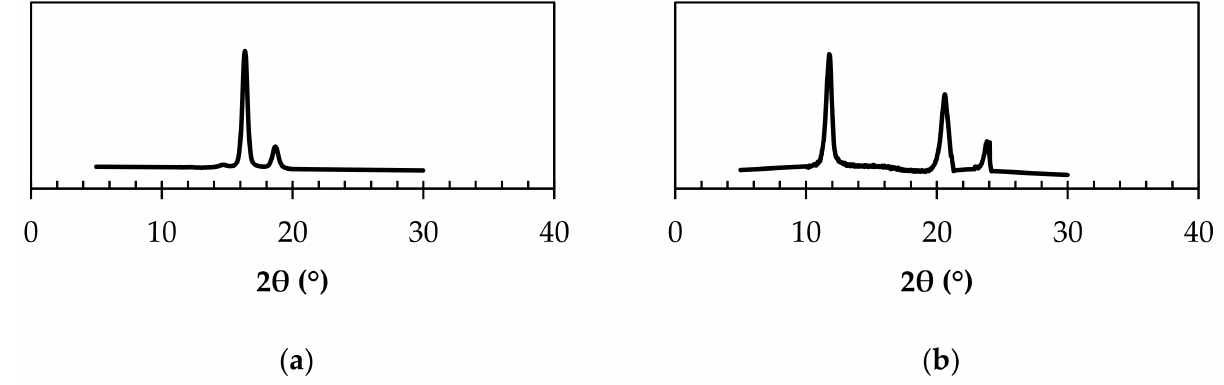
Figure 9. WAXD profiles of ( a ) pure PLLA and ( b ) stereocomplex PLA (50/50